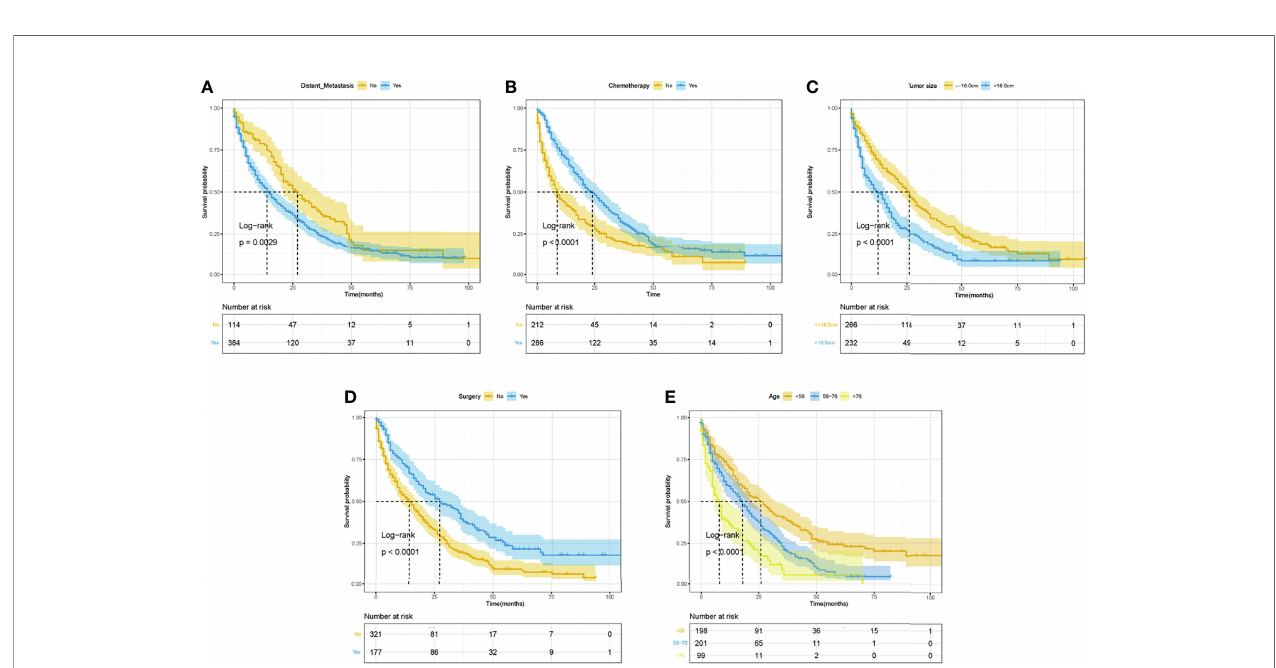
FIGURE 4 | The Kaplan – Meier curves for CSS based on variables for the nomograms. (A) Distant metastasis. (B) Chemotherapy. (C) Tumor size. (D) Surgery. (E) Age. ROC, receiver operating curve; OS, Overall